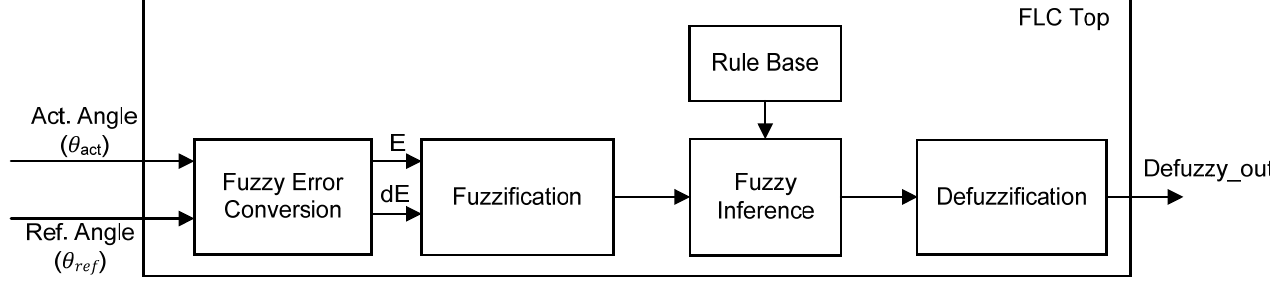
Figure 3. System overview of fuzzy logic controller (FLC).